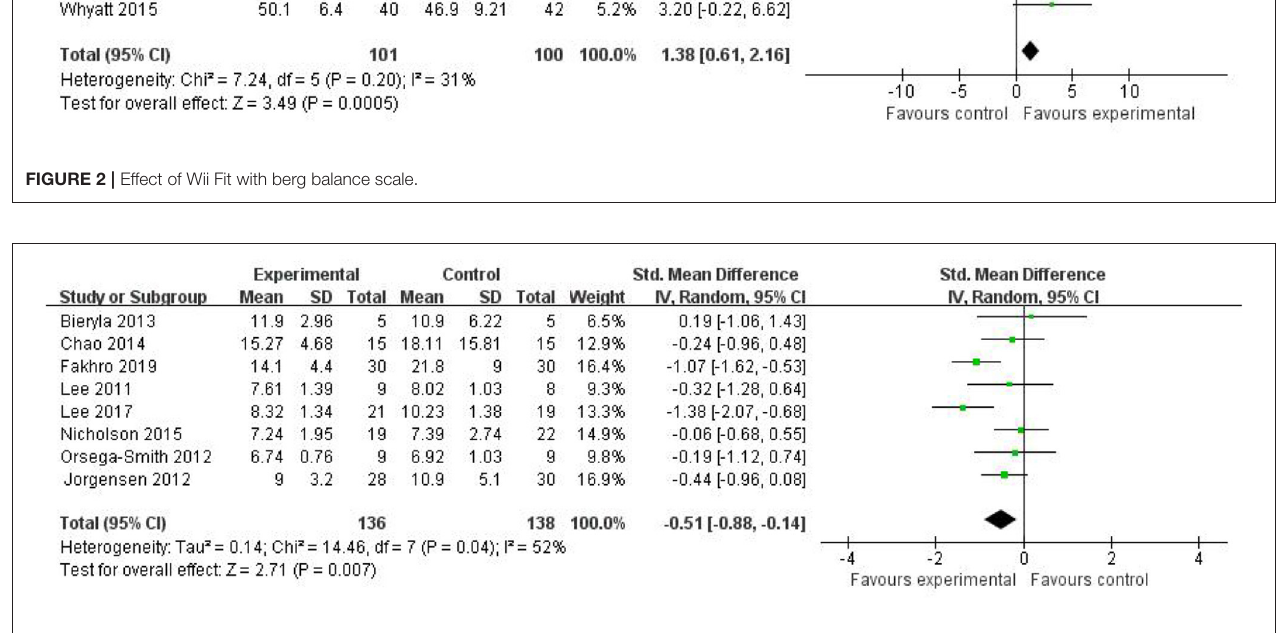
FIGURE 3 | Effect of Wii Fit exercise with timed up and go test.